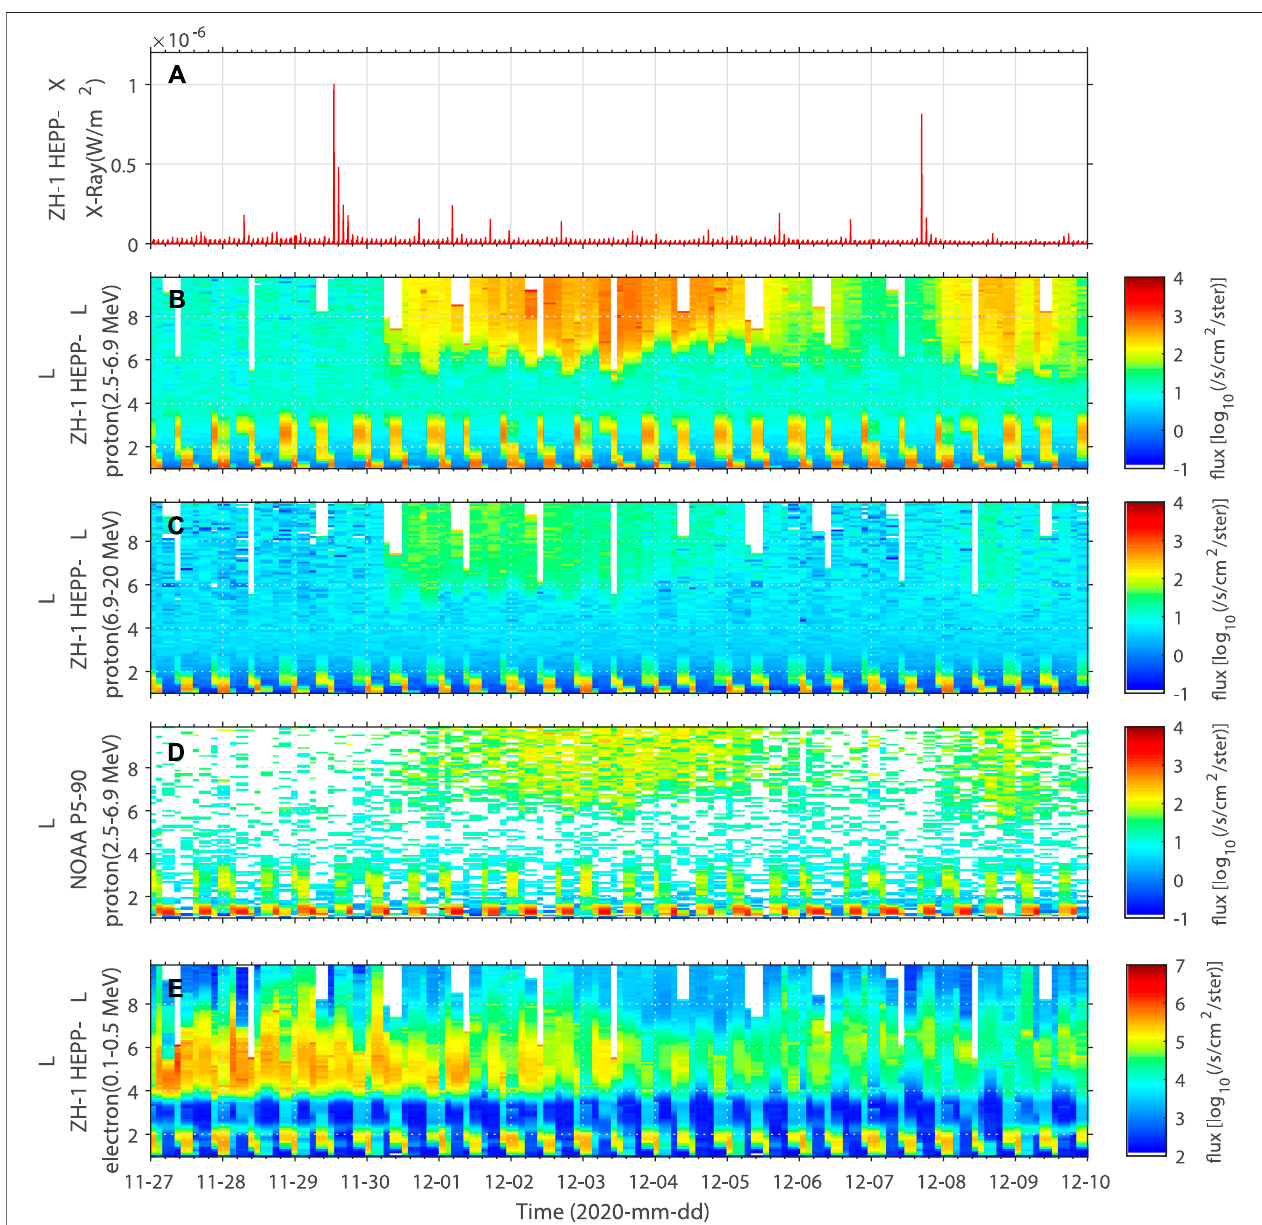
FIGURE 3 | The evolution of X-rays, protons, and electrons during the gradual SPE from 27 November 2020 to 10 December 2020. (A) X-ray fl uxes observed by HEPP-X. (B,C) The proton fl uxes observed by ZH-1 with energies of 2.5 – 6.9 MeV and 6.9 – 20 MeV. (D) The proton fl uxes from the NOAA-19 satellite. (E) 0.1 – 0.5 MeV electron fl ux distribution from